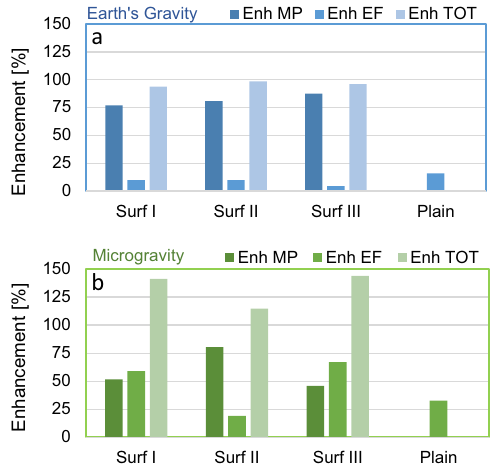
Fig. 5 Critical heat fl ux enhancement achieved for the tested conditions. CHF enhancement with microstructures, electric fi eld, and the combination of both in: a Earth conditions. b Microgravity conditions.